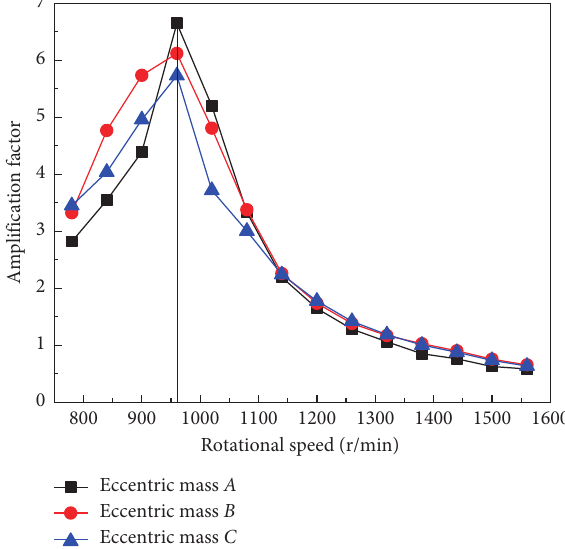
Figure 11: Amplification factor of three eccentric